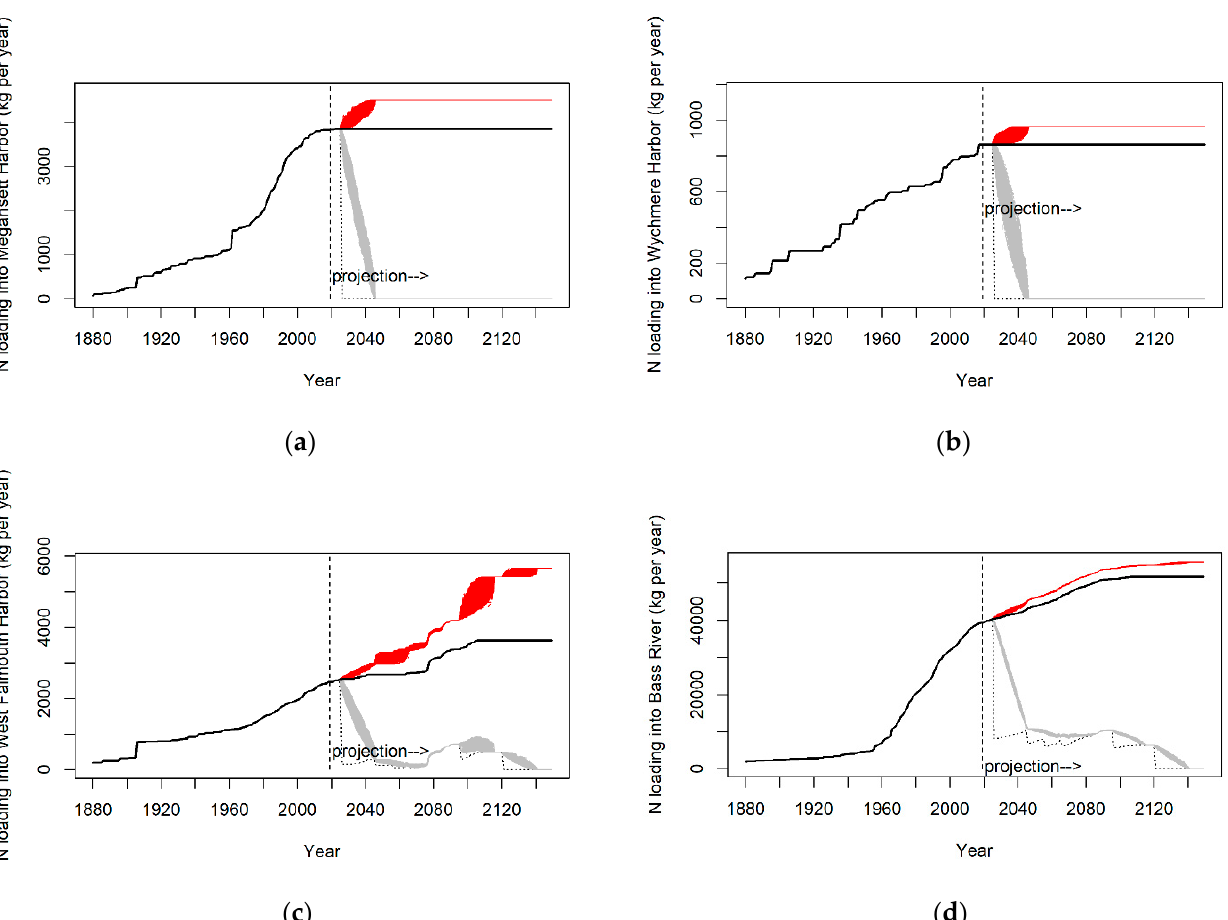
Figure 5. Example bays in equilibrium in terms of watershed N loading sources: ( a ) Megansett Harbor and ( b ) Wychmere Harbor N loading in embayments on Cape Cod, and example bays not in watershed loading equilibrium: ( c ) West Falmouth and ( d ) Bass River. N loading over time to select Cape Cod embayments. The vertical dashed line indicates the current year, to the right of the dashed line is the projected N load. The top two graphs depict bays in equilibrium where, all other things held equivalent, future loading ≈ current loading. The bottom two graphs depict bays where future N load will exceed current loading. For all four bays the results from the Monte Carlo analysis in the upper-bound scenario are indicated by red lines, and the lower-bound scenario results are indicated by gray lines. The thin dotted black line at the bottom is the legacy N scenario. Note: y -axis scale varies by estuary. See Appendix B for complete N loading time series results.